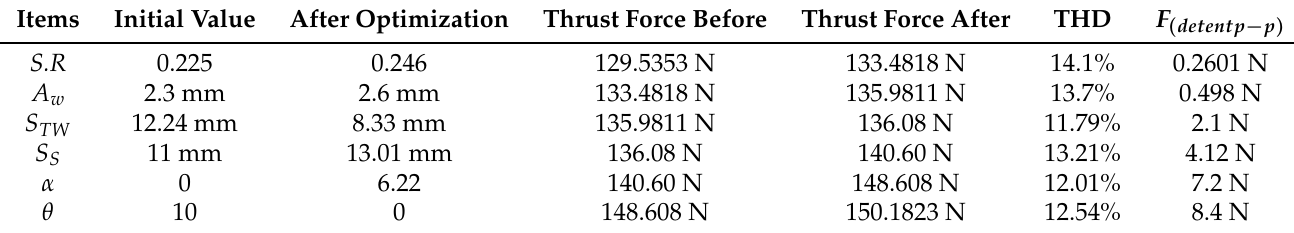
Table 5. Overall performance of the machine.